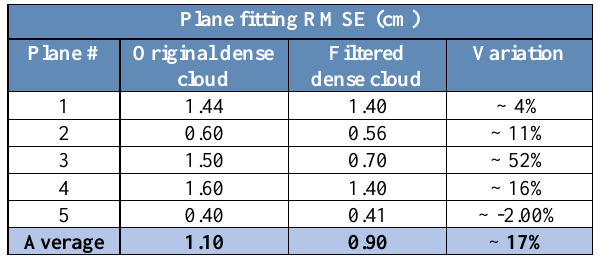
Figure 8: Graphical representation of the tested weights combinations. The highlighted box shows the combination yielding the best results in terms of quality feature improvements (see also Table 3).